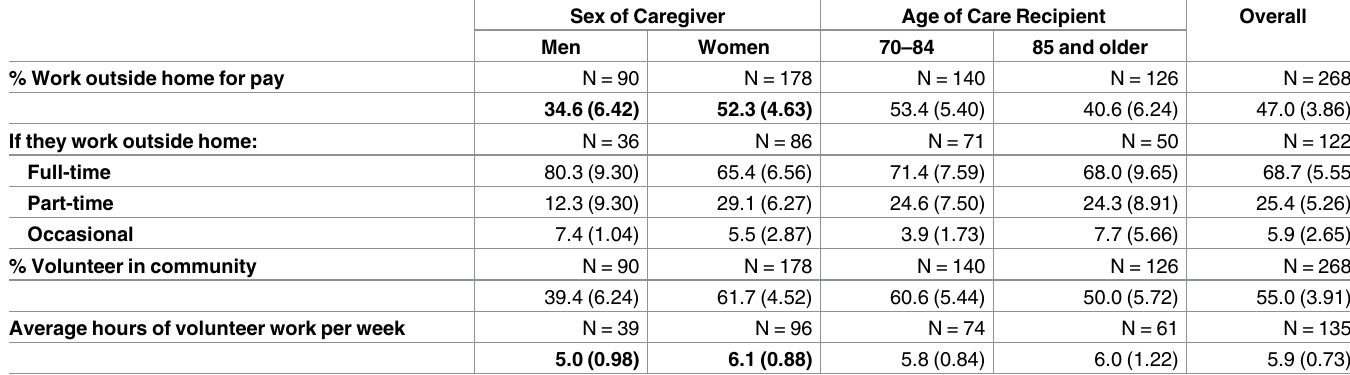
Table 2. Transportation caregiveremployment and volunteer work by sex, age of care recipient, and overall (standard error of the